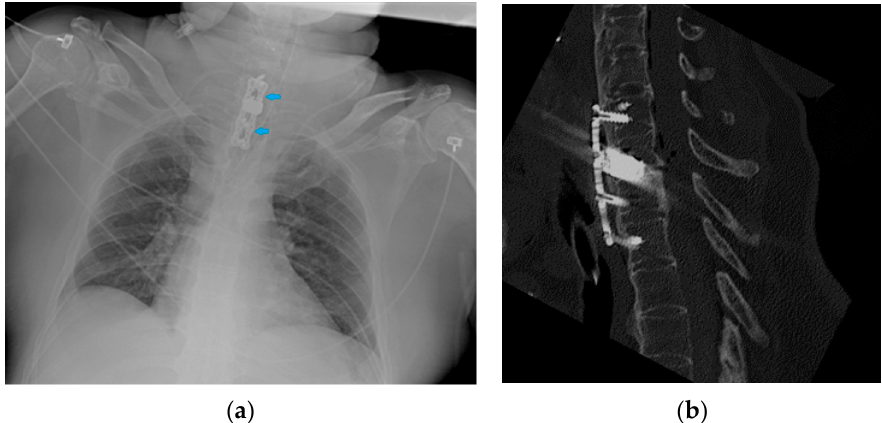
Figure 35. Image of an anterior spine stabilizer (blue arrows) on CXR ( a ) and the corresponding image on the CT scan ( b ).